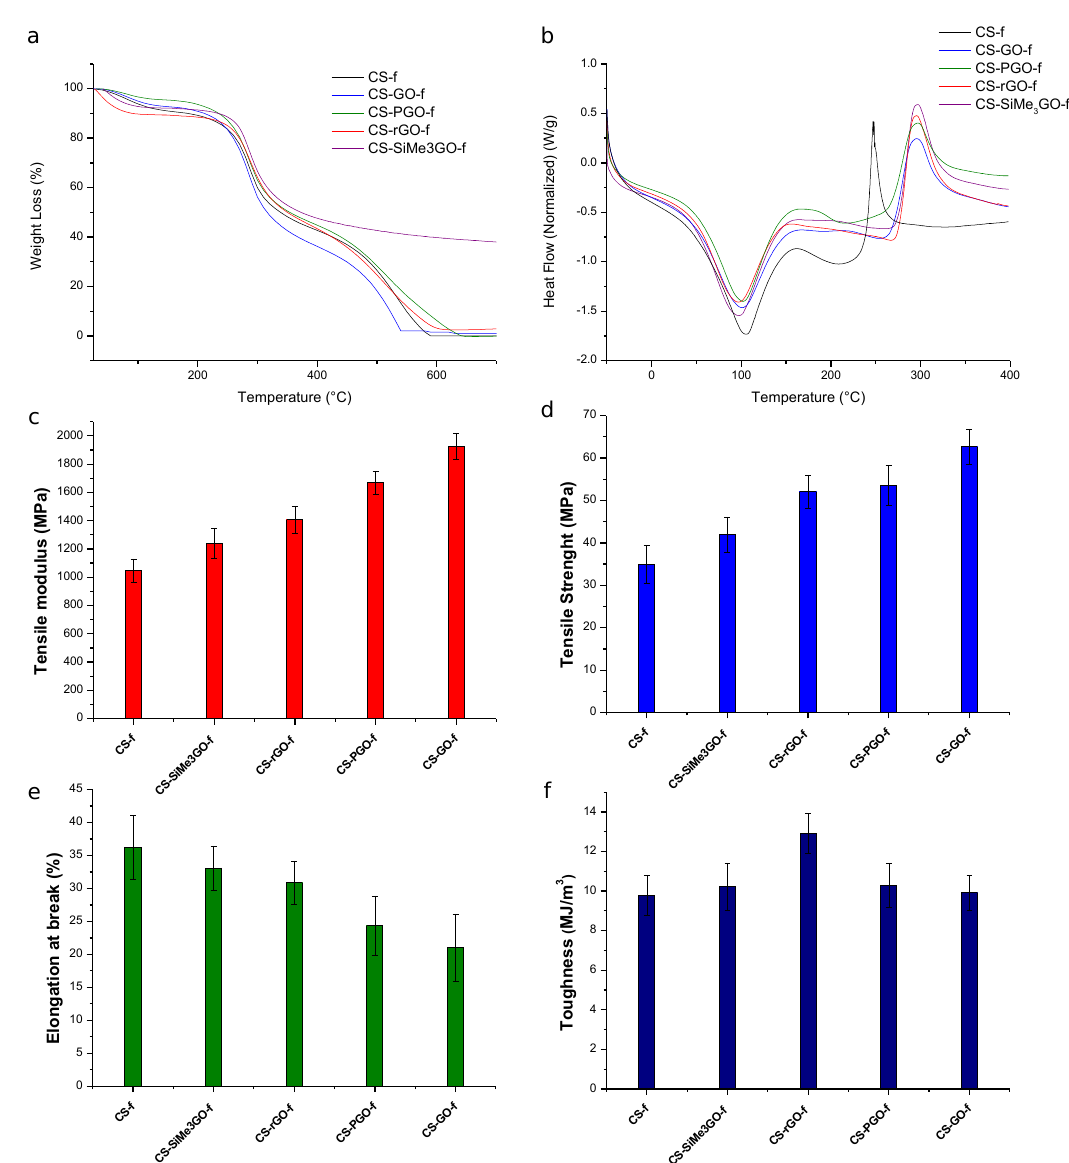
Figure 4. Thermal and mechanical properties of the resulting nanocomposites. ( a ) Thermogravimetric analysis (TGA), ( b ) Differential scanning calorimetry (DSC), ( c ) Tensile modulus, ( d ) Tensile strength, ( e ) Elongation at break, and ( f ) Toughness.